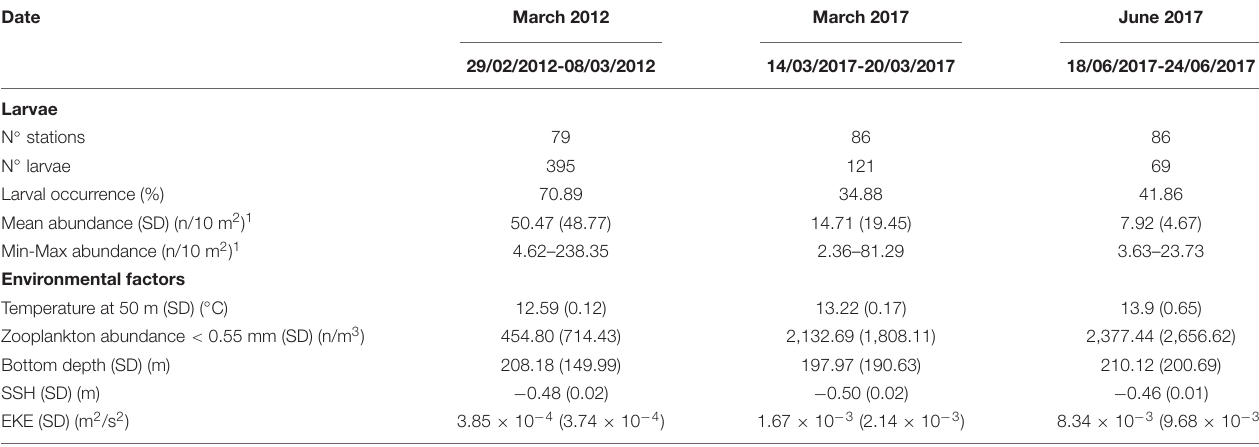
( Table 2 ). The variables in the order of the greatest (cid:49) AIC were longitude and latitude ( (cid:49) AIC = 23.61), year ( (cid:49) AIC = 14.78),